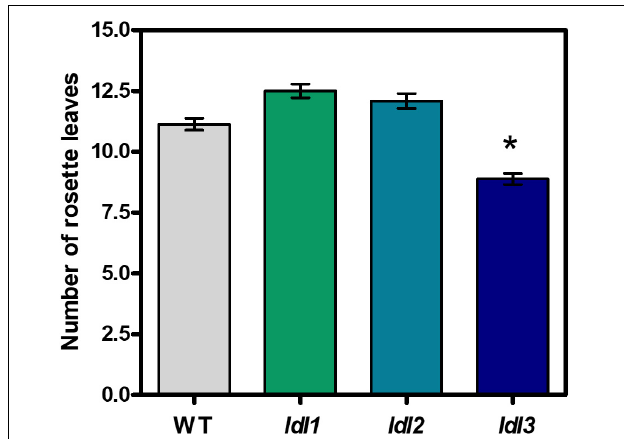
FIGURE 7 | Flowering time of ldl / fld loss-of-function Arabidopsis mutants for LDL / FLDs . Flowering time of ldl1 , ldl2 , ldl3 mutants and wild-type plants (WT) is expressed as the number of rosette leaves at bolting. The fld mutant plants presented non-flowering phenotype under our growth conditions. Mean values ( n > 8) of a representative analysis out of at least three repetitions are shown and bars indicate standard error. Asterisk indicates statistically significant differences from WT plants (one-way ANOVA test, p < 0.05).